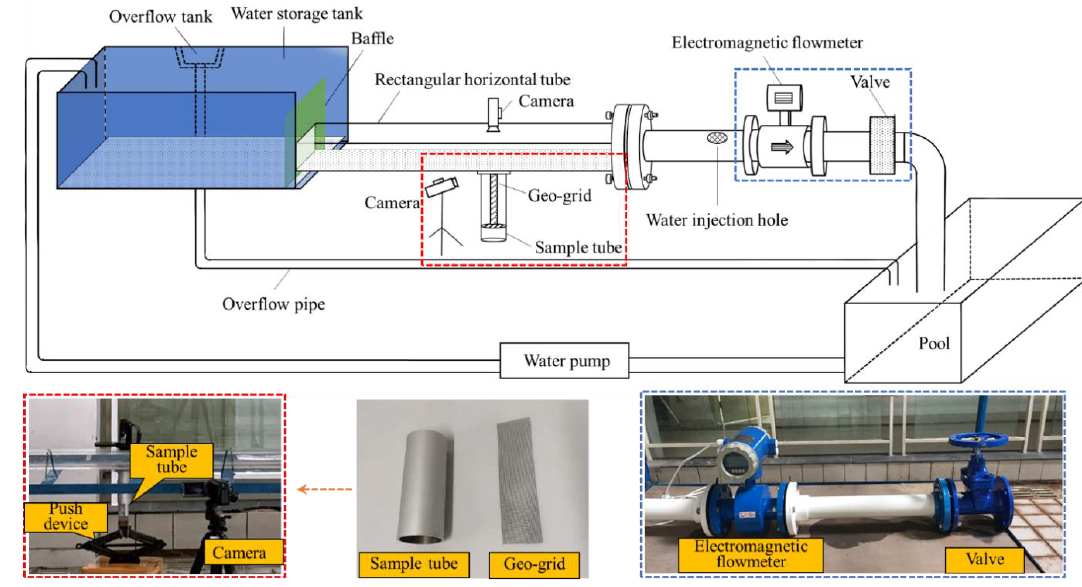
Figure 1. Reinforced tailings incipient motion test facility.